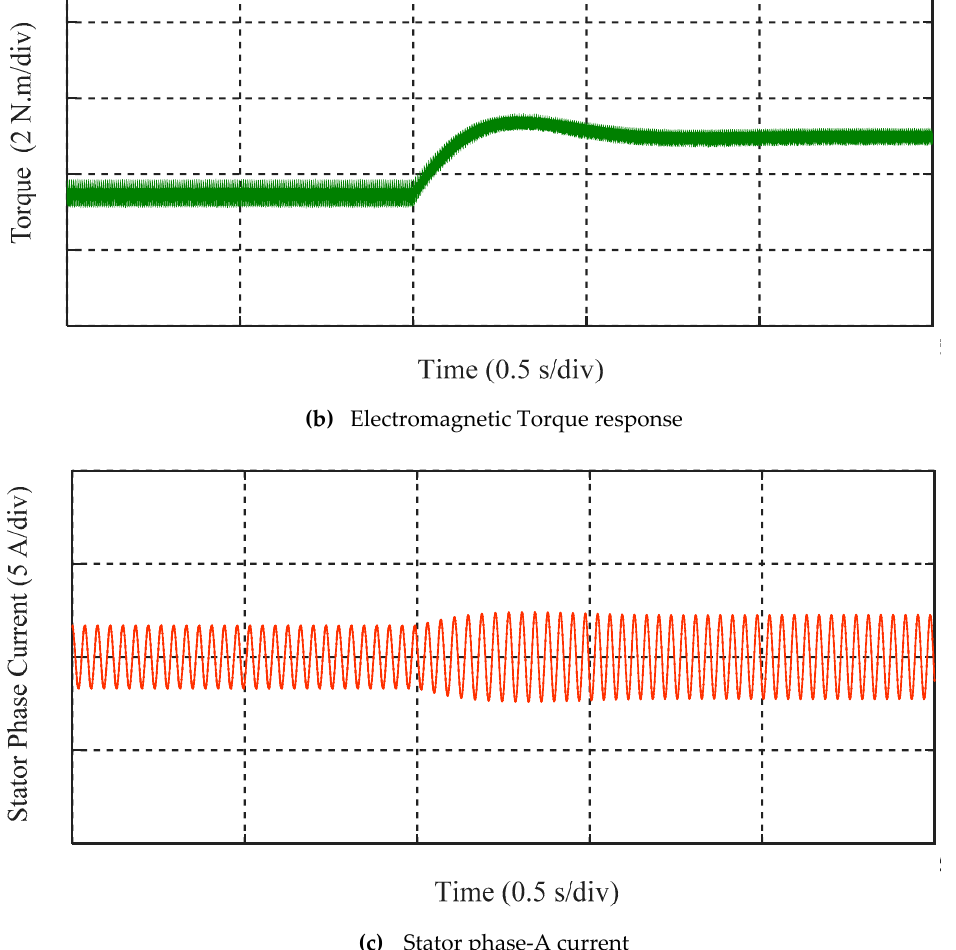
Figure 22. Experimental validation of the proposed sensorless system for IM drives under the load change condition.